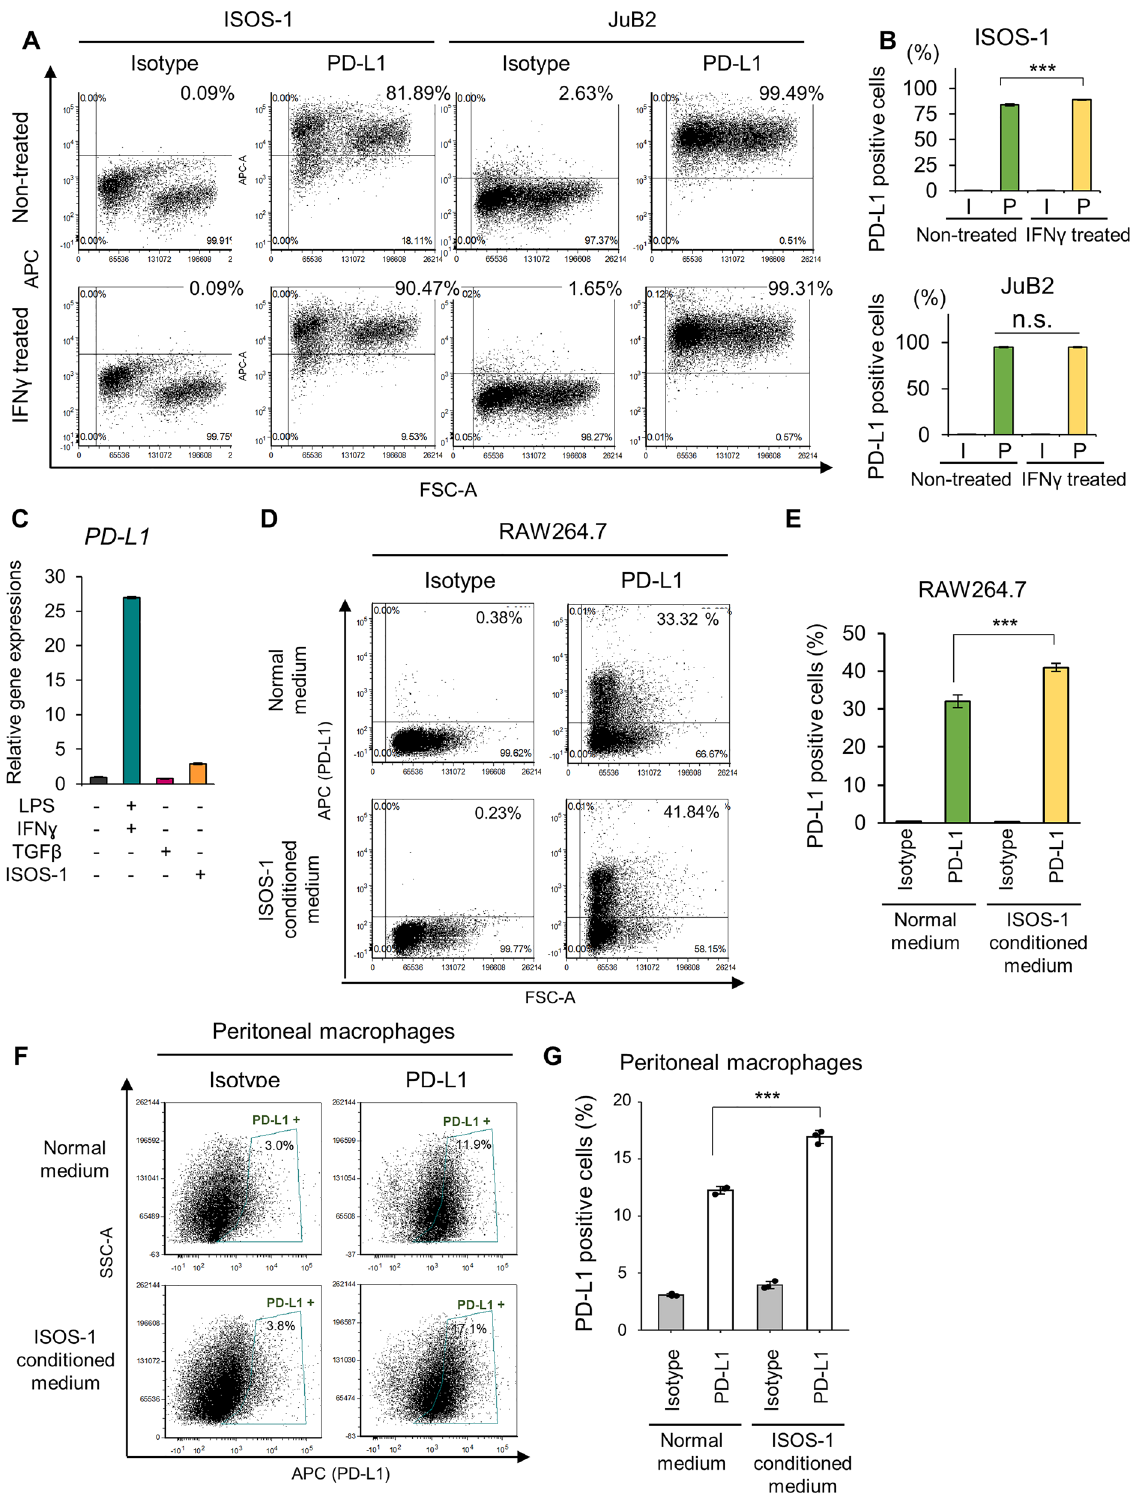
Figure 4. ISOS-1 cells induce PD-L1 expression in RAW264.7 cells. ( A ) Representative images of flow cytometry analysis for PD-L1 in ISOS-1 and JuB2 cell lines with/without IFNγ treatment. APC indicates PD-L1 expressions. ( B ) Quantitative analysis of A . ( C ) Gene expression levels of PD-L1 in untreated, LPS and IFN- treated, TGFβ-treated, and ISOS-1 conditioned media-treated RAW264.7 cells. ( D ) Representative images of flow cytometry analysis for PD-L1 in RAW264.7 cells cultured in normal or ISOS-1 conditioned media. ( D ) Quantitative analysis of ( C ). ( E ) Representative images of flow cytometry analysis for PD-L1 in mouse peritoneal macrophages cultured in normal or ISOS-1 conditioned media. ( F ) Quantitative analysis of ( E ). Data are presented as mean values ± s.d. *** P < 0.001, Tukey’s